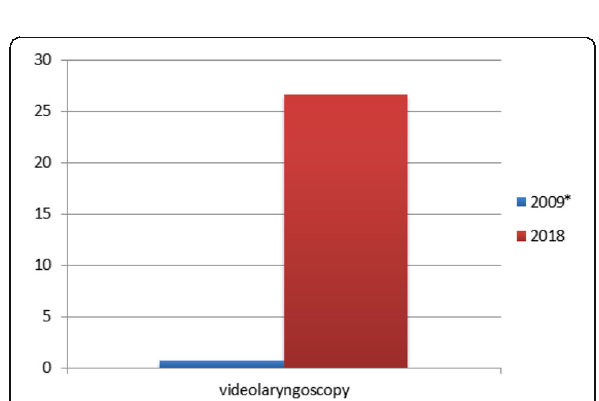
Fig. 2 (abstract 000295). See text for description. *nationwide 2009